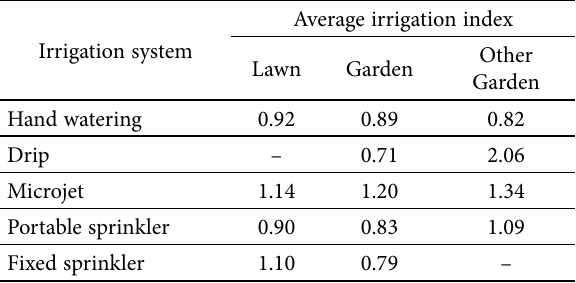
Table 7. Variation of average irrigation index with irrigation systems and irrigation zones